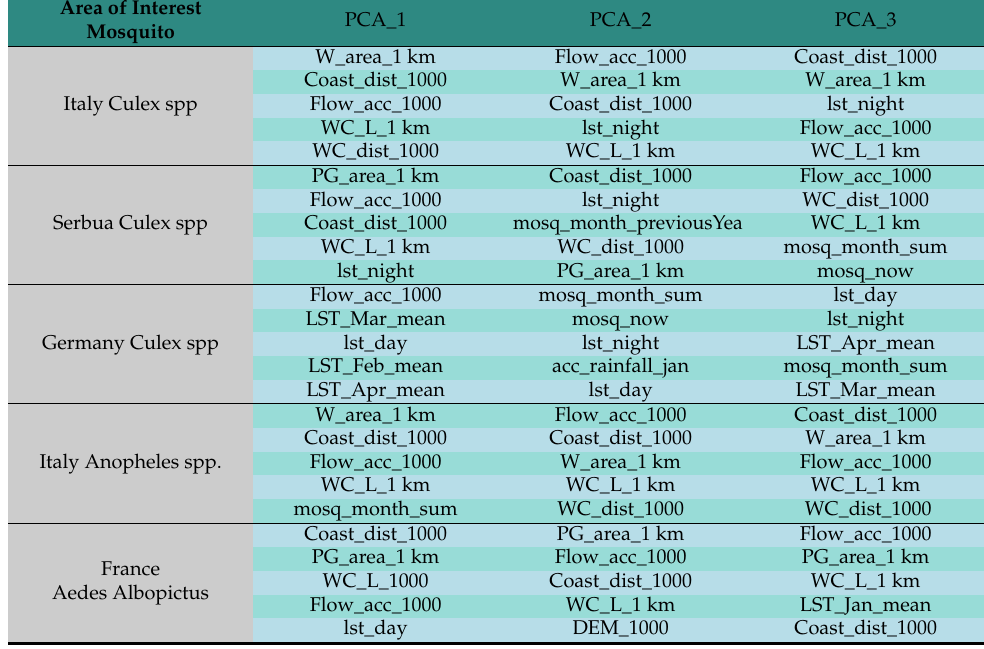
Table 5. PCA features most significant components per case using both EO and entomological